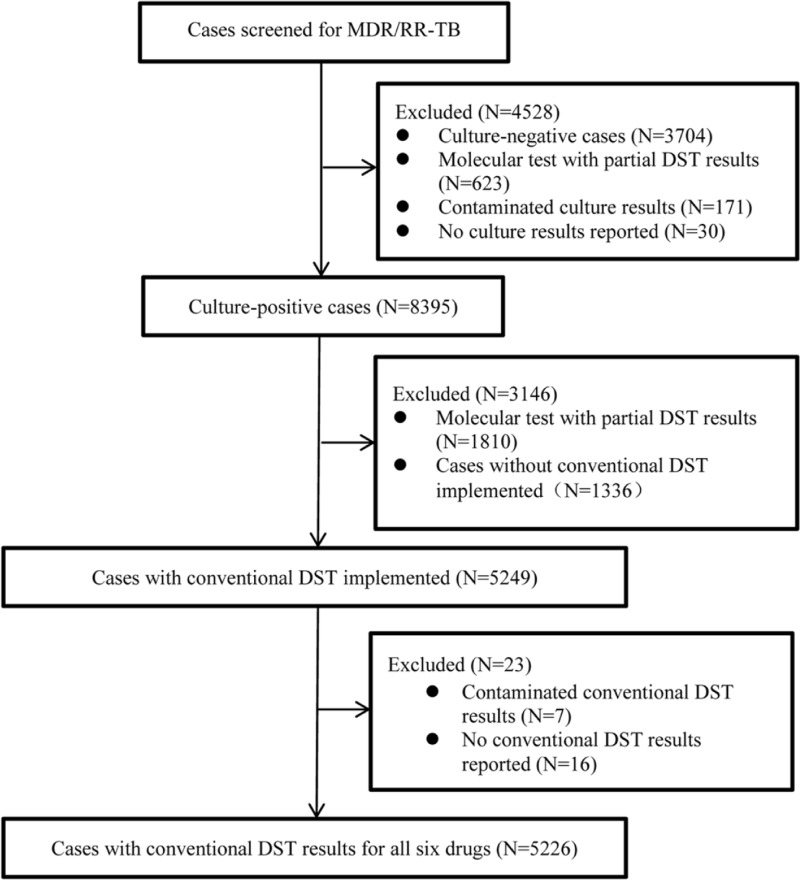
The flow chart of cases tested with conventional DST from 2010 to 2017.